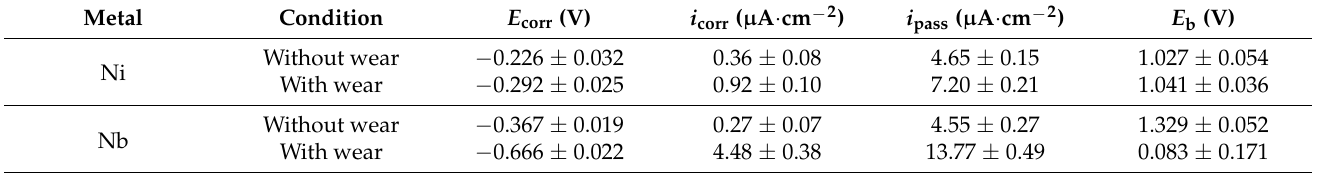
Table 1. Electrochemical corrosion parameters from the potentiodynamic polarisation